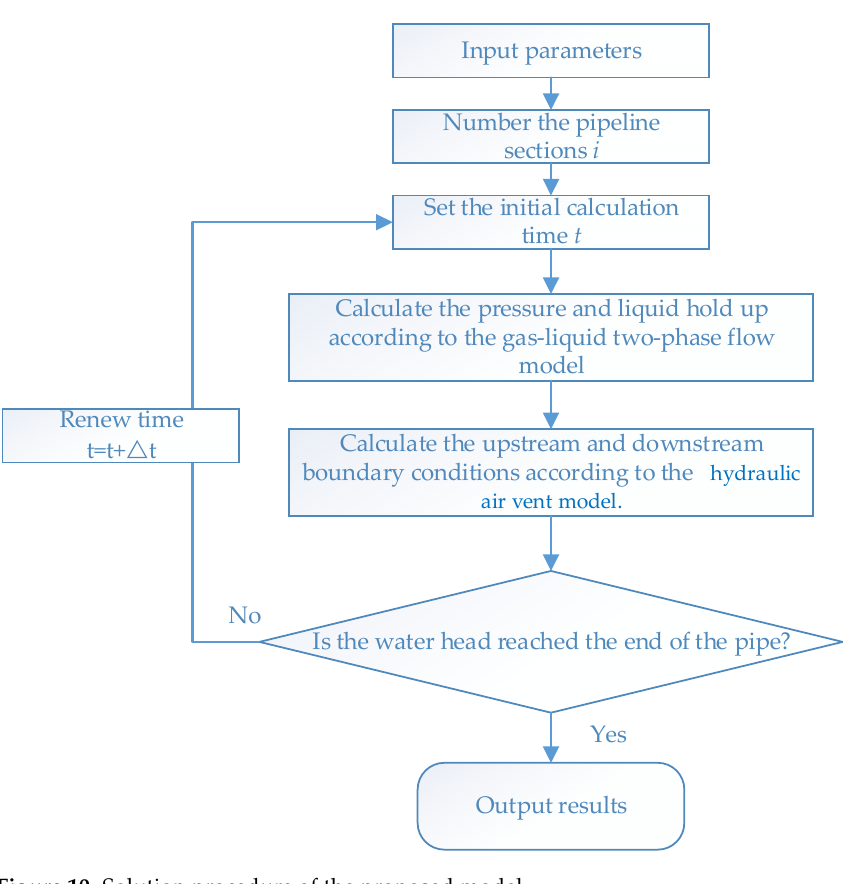
Figure 10. Solution procedure of the proposed model.